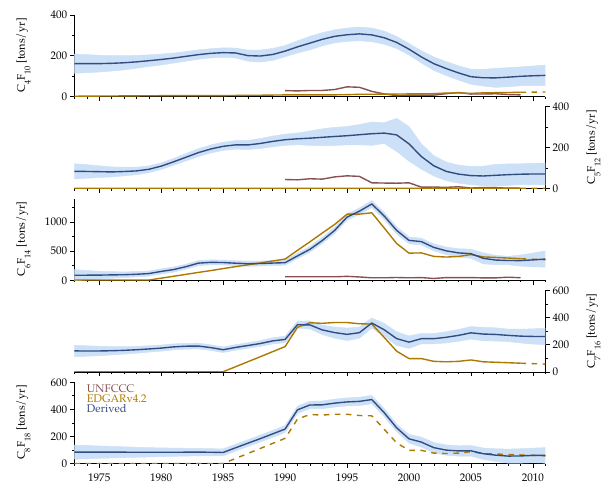
Fig. 4. The global annual emissions for C 4 F 10 , C 5 F 12 , C 6 F 14 , C 7 F 16 and C 8 F 18 derived in this study are shown as the solid blue line, and the associated 1- σ uncertainty in the emissions is rep- resented as the light blue shading. The available bottom-up emis- sions data are also shown from EDGARv4.2 (solid yellow line) and UNFCCC (solid purple line). The interpolated data used in the reference run from EDGARv4.2 from 2009 to 2011 are shown as the dashed blue line, and the C 8 F 18 reference emissions are also shown as a dashed line, as no bottom-up estimates are available and C 7 F 16 ’s emissions were used as a